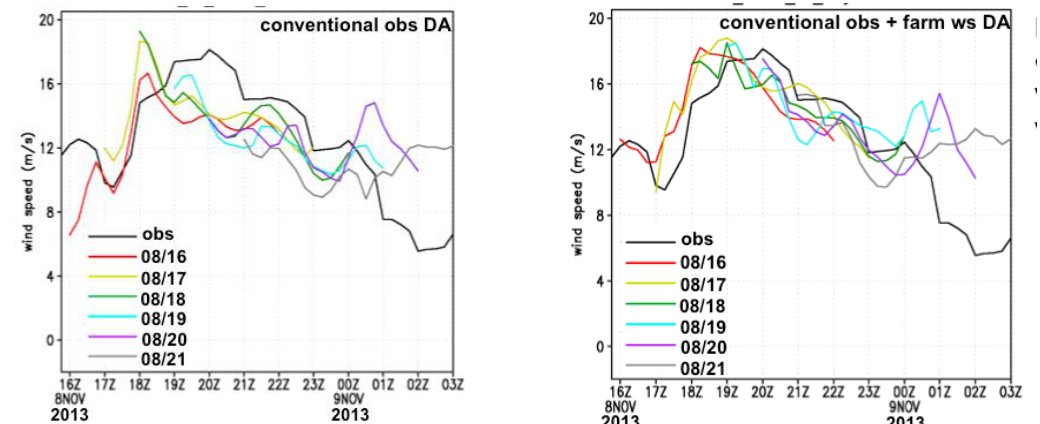
Figure 2. Comparison of hourly data assimilation and forecasting cycles without ( left panel ) and with ( right panel ) assimilation of wind turbine hub-height wind speed observations for a large wind farm in Northern Colorado. The black lines show the mean wind. Different color lines represent forecasts from different cycles with the first (last) two digits in the legend denoting the day of the month (hour in UTC). Conventional obs DA: conventional observation data assimilation and farm ws DA: farm wind speed data assimilation.